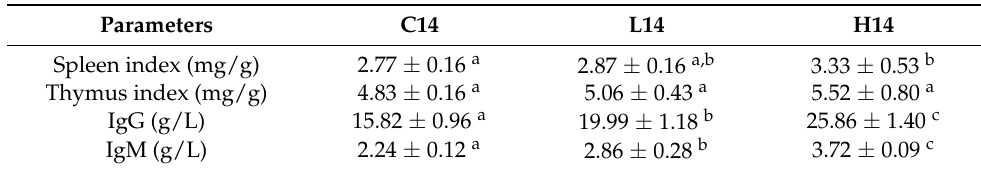
Table 3. Immune parameters of each group after 14 days of